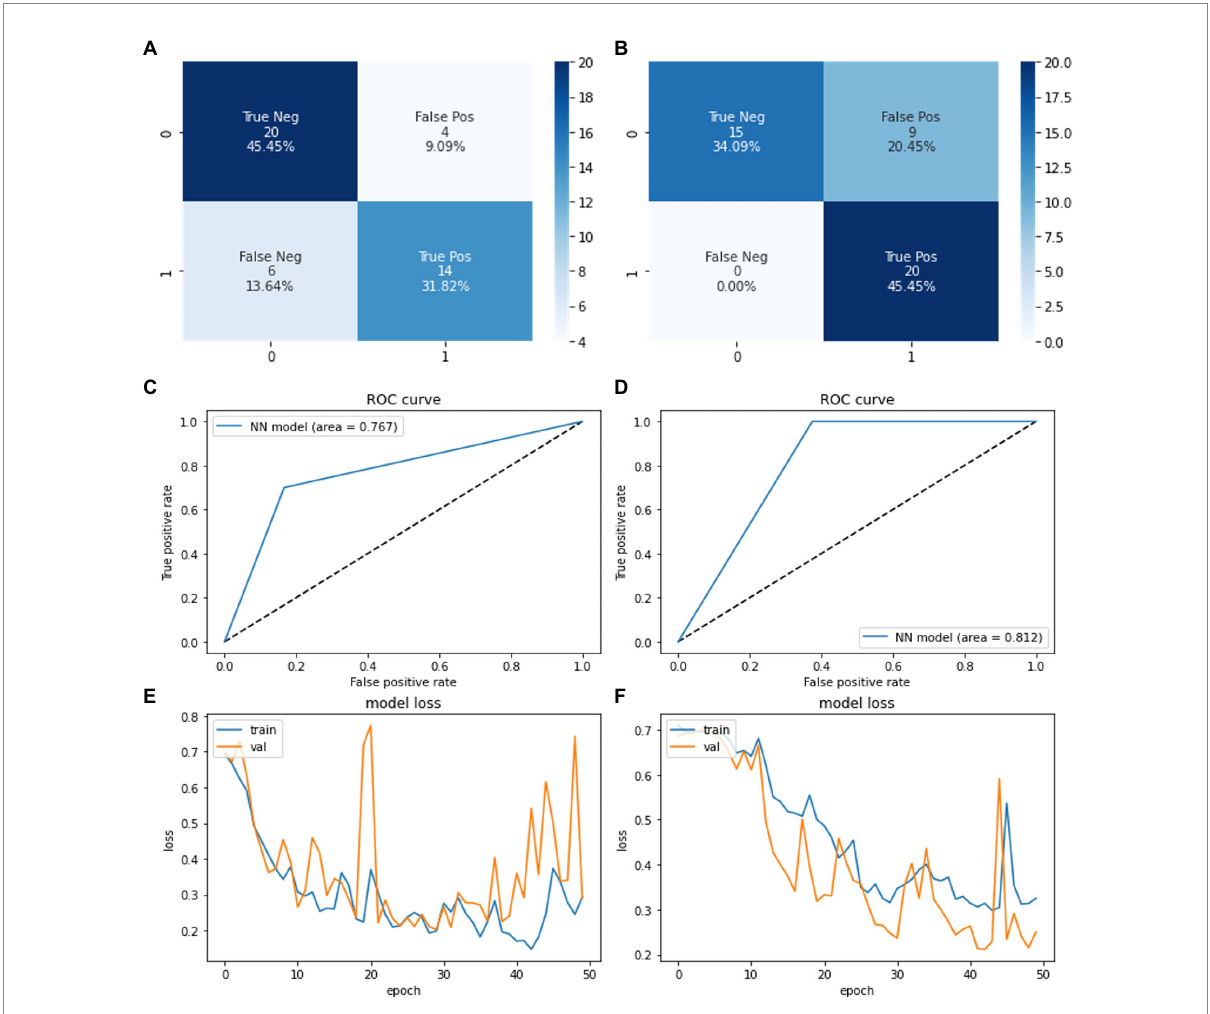
FIGURE 6 Confusion matrices showing the system performance of neural network (A) on VAE based synthetic data (B) on GAN based synthetic data. ROC curve showing the system performance of neural network model on (C) VAE generated synthetic data (D) GAN generated synthetic data. Training loss vs. epoch graph of neural network on (E) VAE based synthetic data (F) GAN based synthetic